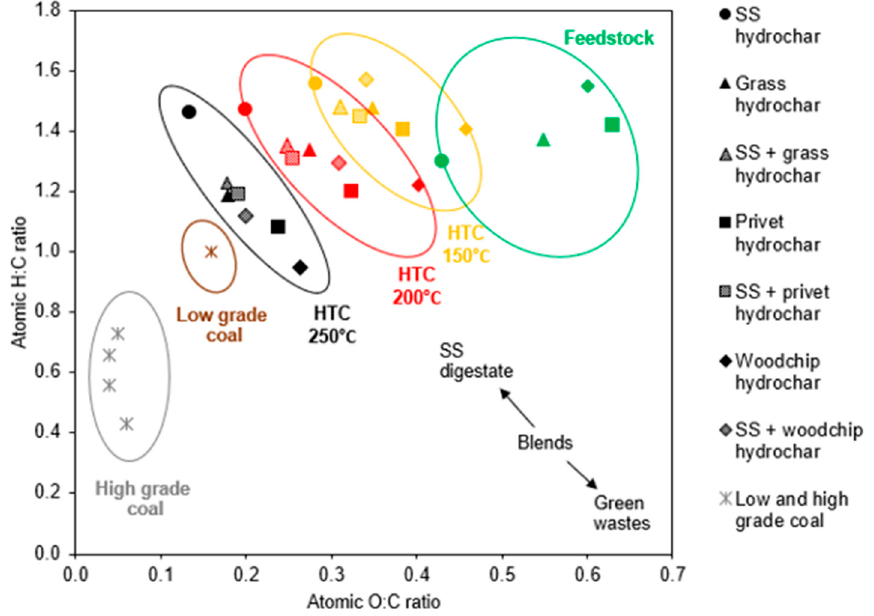
Figure 7. Van Krevelen diagram for lignocellulosic biomass, SS digestate feedstock, and resultant hydrochars, including blends on a dry ash free basis.